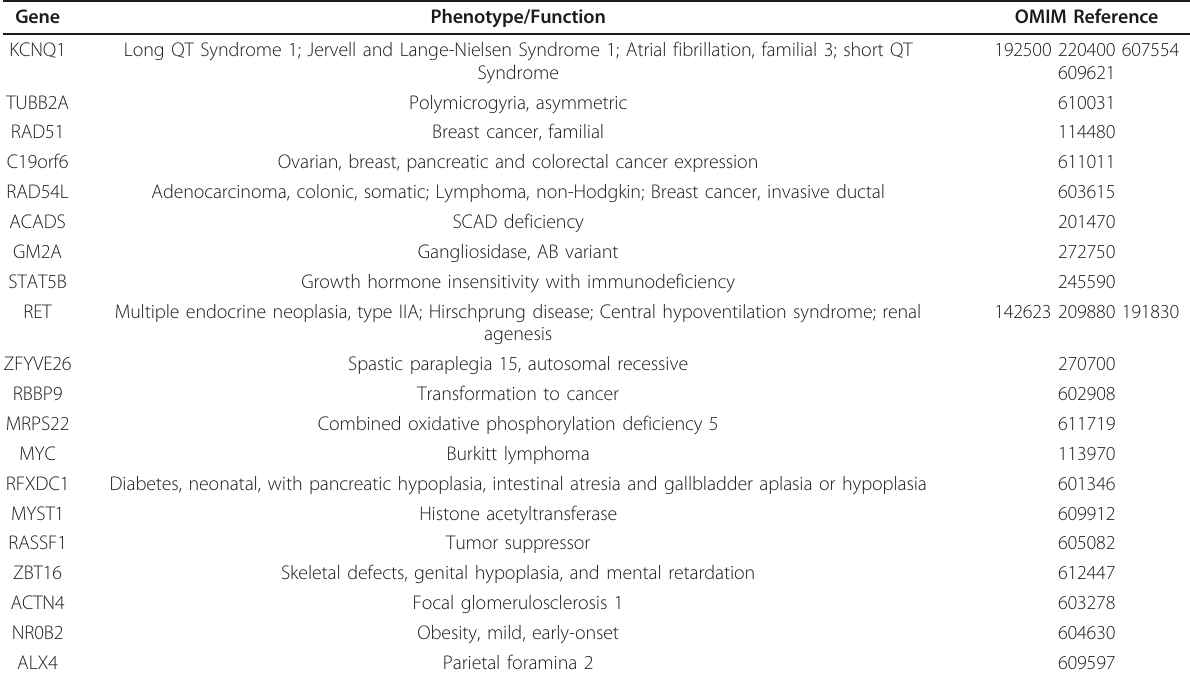
Table 3 Diseases and functions reported to be associated with genes exhibiting a significant correlation between methylation and maternal